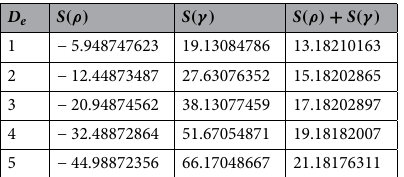
Table 3. Numerical results for the uncertainty relation S (ρ) + S (γ) ≥ ( 1 + log π) at the ground state.